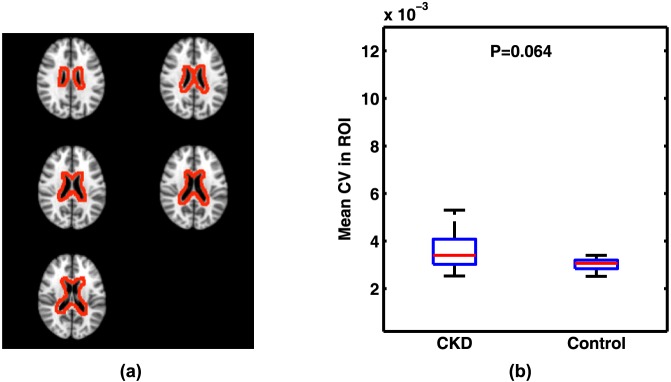
Mean CV measured in an area possibly susceptible to non-rigid body movements in the brain (interface between the lateral ventricles and brain parenchyma).(a): The ROI used for calculations. (b): Mean CV values calculated in the ROI.